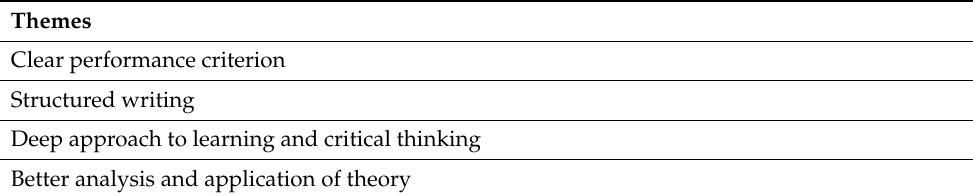
Table 3. Themes of open-ended